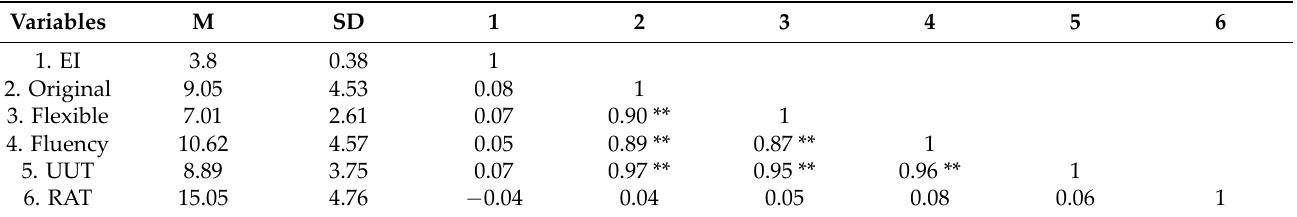
Table 2. Descriptive statistics and correlations between EI and creativity thinking.